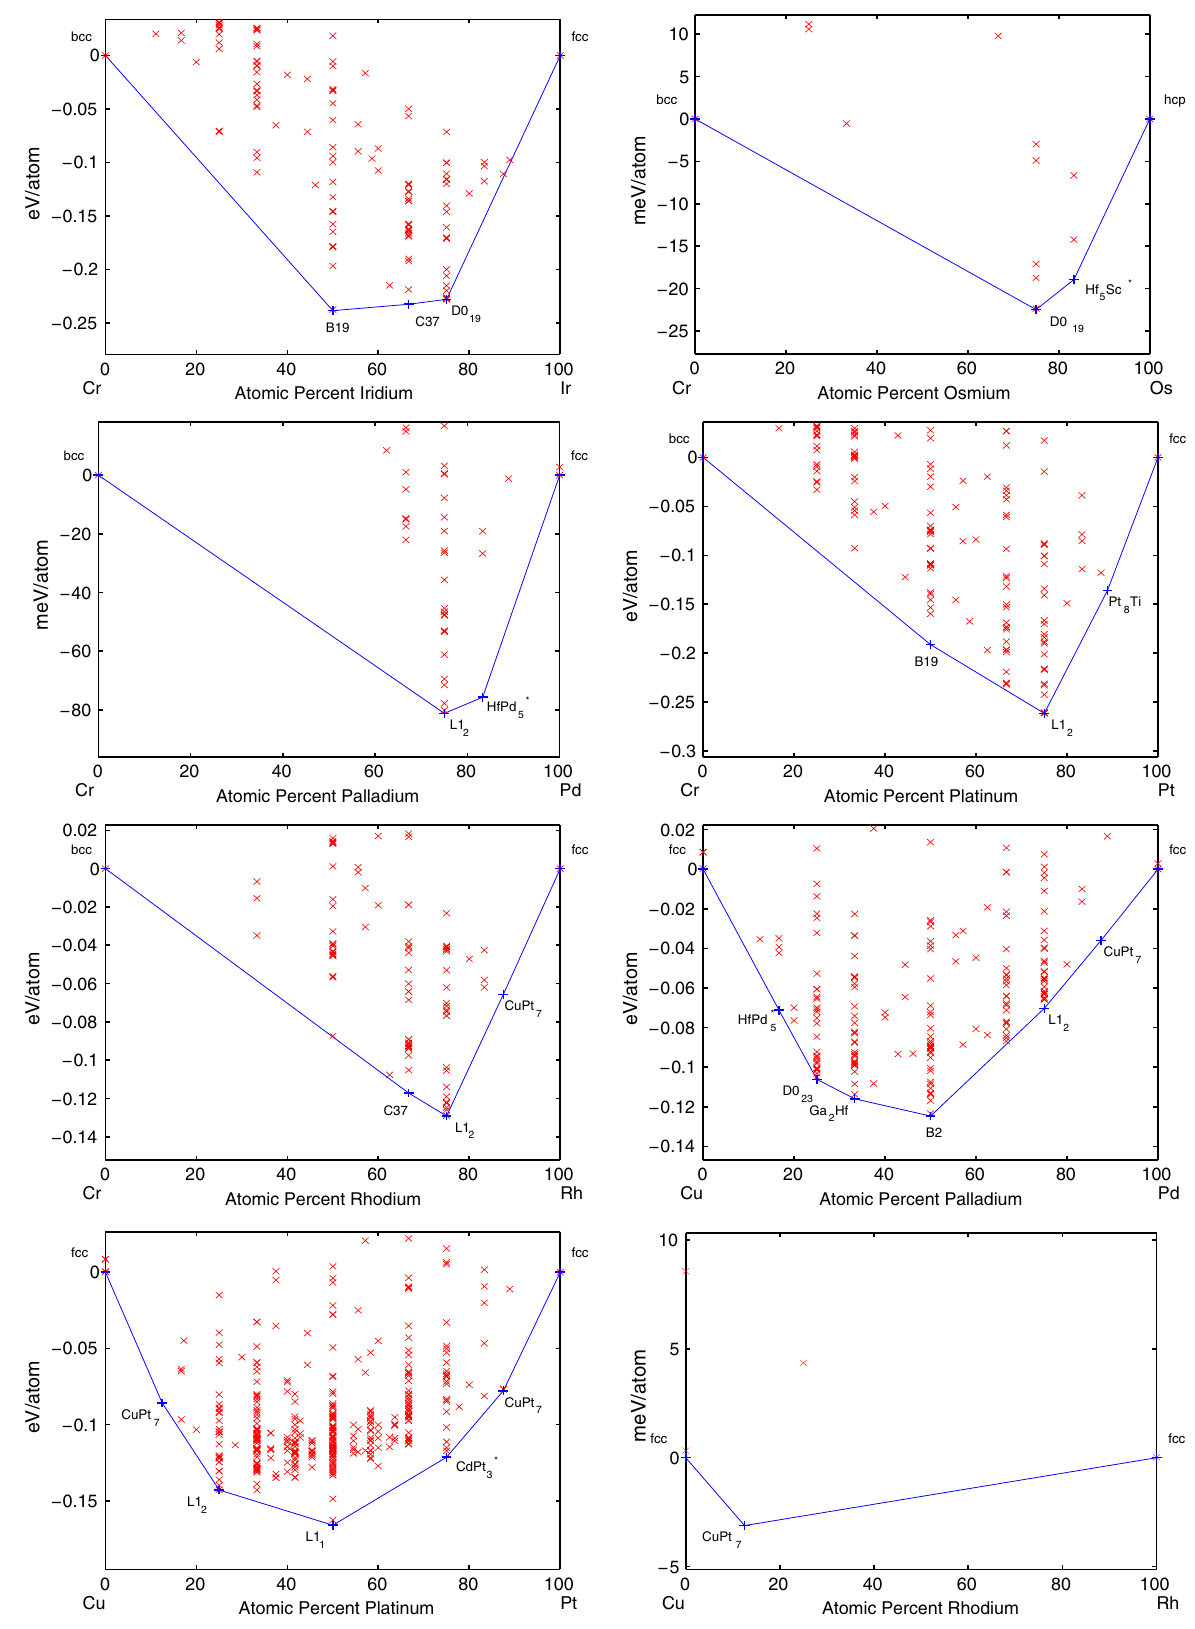
FIG. 6. Convex hulls for the systems Cr-Ir, Cr-Os, Cr-Pd, Cr-Pt, Cr-Rh, Cu-Pd, Cu-Pt, and